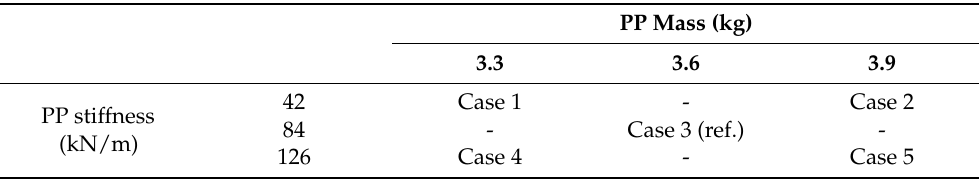
Table 2. Experimental design with parameters of PP mass and PP spring stiffness (DP mass of 1.64 kg and DP stiffness of 84 kN/m for all cases).